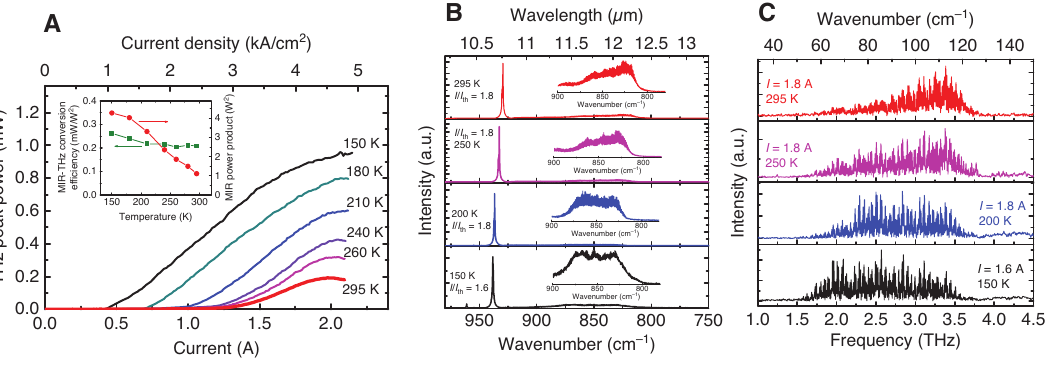
Figure 6: Temperature characteristics of the DFB/FP DFG-QCL. (A) Current-THz-light-output characteristics of the 14- μ m-wide and 3-mm-long DFG-QCL at different heat sink temperatures measured in pulsed mode [48]. Inset shows the temperature dependence of the mid-IR-to-THz conversion efficiency (left axis) and product of mid-IR pump powers (right axis). Mid-IR (B) and THz (C) emission spectra of the device in (A) at different temperatures. The insets in panel (B) show mode details of the FP pump spectra.